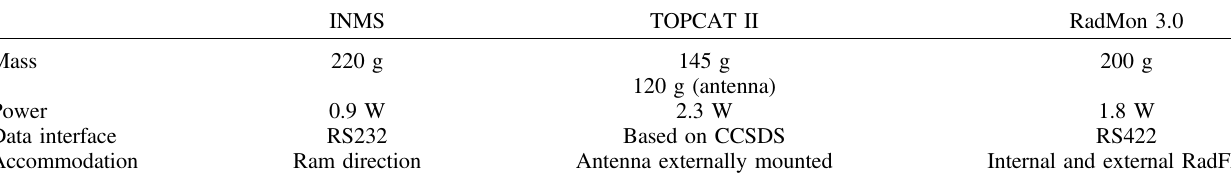
Table 1. Key attributes of the IRIS payloads.